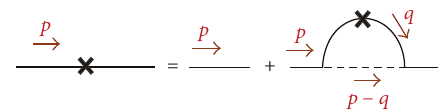
Figure 6: Gap equation for large Yukawa coupling in the ladder approximation, where vanishing 𝑚 0 is